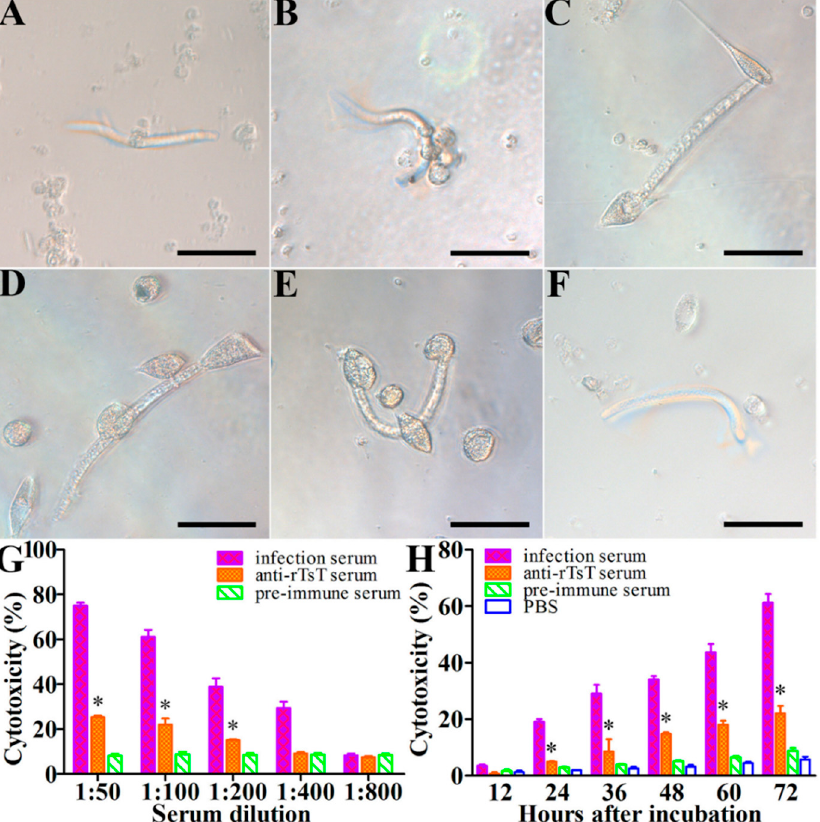
Figure 12. Cytotoxic activity of PECs on the NBL in the presence of anti-rTsT immune serum. ( A–D ): Morphology of T. spiralis newborn larvae co-incubated with the PECs and anti-rTsT immune serum for 24 h (A), 48 h (B), 60 h (C) and 72 h (D). ( E ) T. spiralis -infected murine sera as positive control. ( F ): Pre-immune sera as negative control. Bar, 100 µm. ( G ): The cytotoxic activity of anti-rTsT immune serum was antibody dose-dependent. ( H ): The cytotoxic activity of anti-rTsT immune serum was also related to the incubation time. * Significantly different with respect to the pre-immune serum group (* p < 0.01).